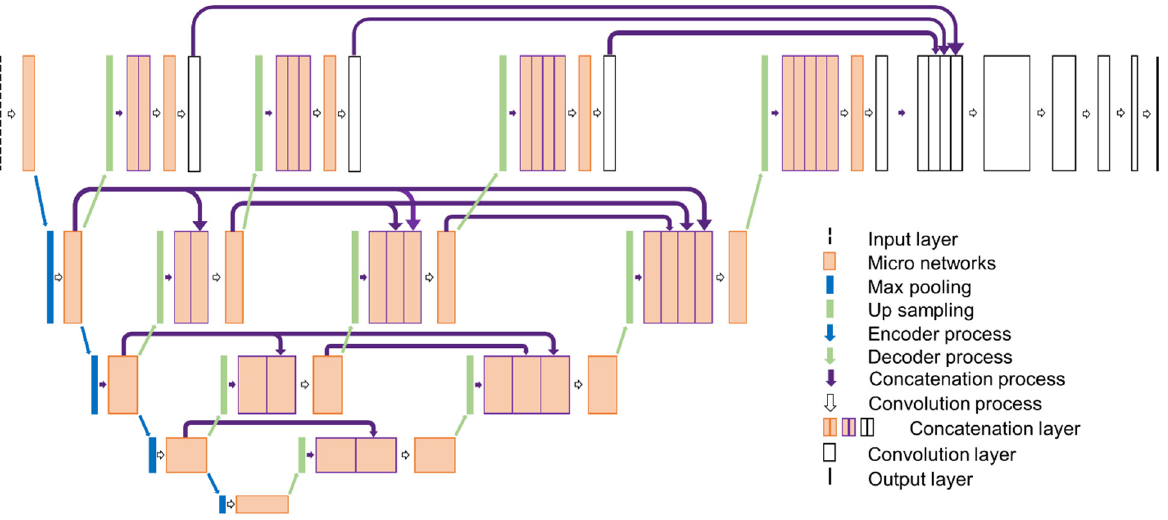
Figure 4. The proposed rock segmentation network